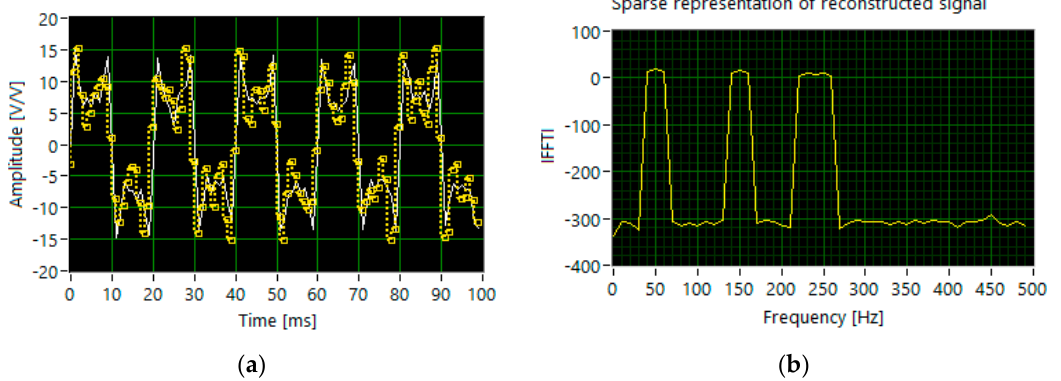
Figure 9. The results of simulation for the input signal (set 1) with the additive noise: ( a ) the segments of time waveforms of the original (white line) and reconstructed signal (dotted yellow line); ( b ) DFT components of the reconstructed signal. The number of measurements is equal to 210.